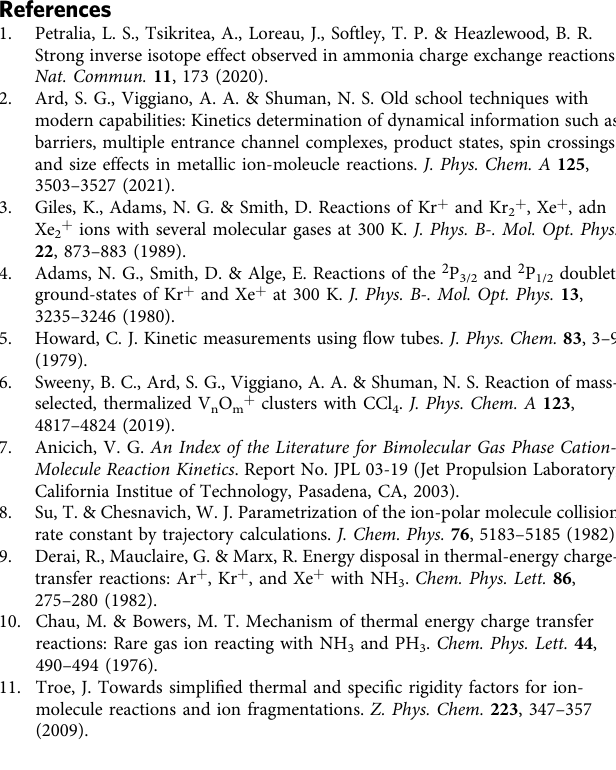
Fig. 2 Comparison of kinetic isotope effects for Xe + + NH 3 /ND 3 . Experimentally determined kinetic isotope effect ( k (Xe + + NH3) / k (Xe + + ND3) ) as a function of temperature derived from the present work (circles) and of Petralia et al. (ref. 1 ) squares. Error bars indicate the 95% con fi dence